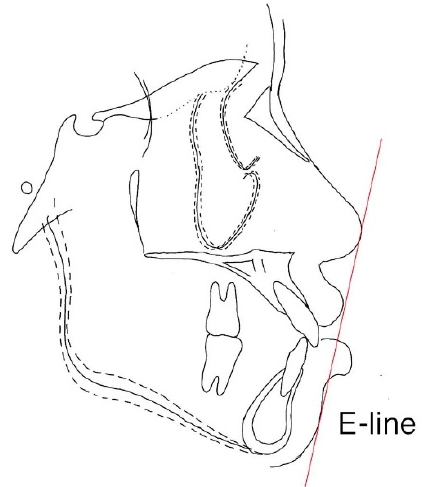
Figure 6. Z angle. The angle is formed by the Frankfort horizontal plane angle and soft tissue profile.